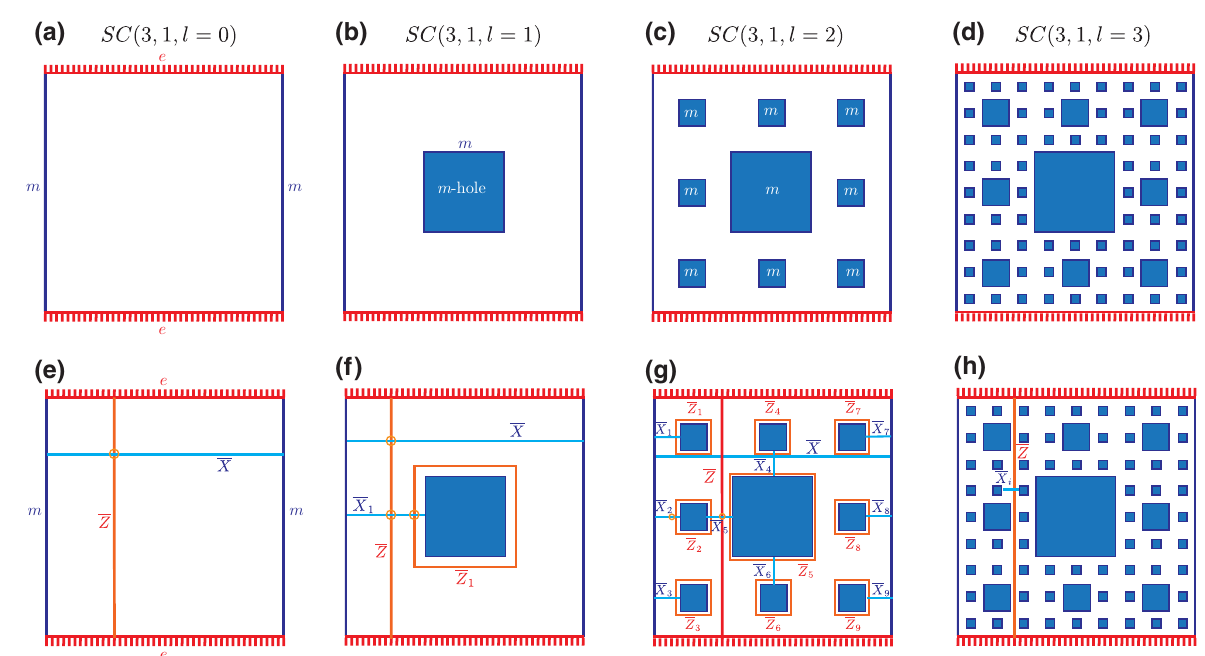
FIG. 5. (a)–(d) The recursive definition of the fractal models with the external boundaries of the surface code and m -holes inside. (e)–(h) The logical string operators in each iteration. (f)–(h) Any representative of the macroscopic logical Z -string, such as Z illustrated in the figure, always intersects with a short logical X -string, which will have O ( 1 ) length in the final iteration, as illustrated in (h) in this example. This leads to an O ( 1 ) code